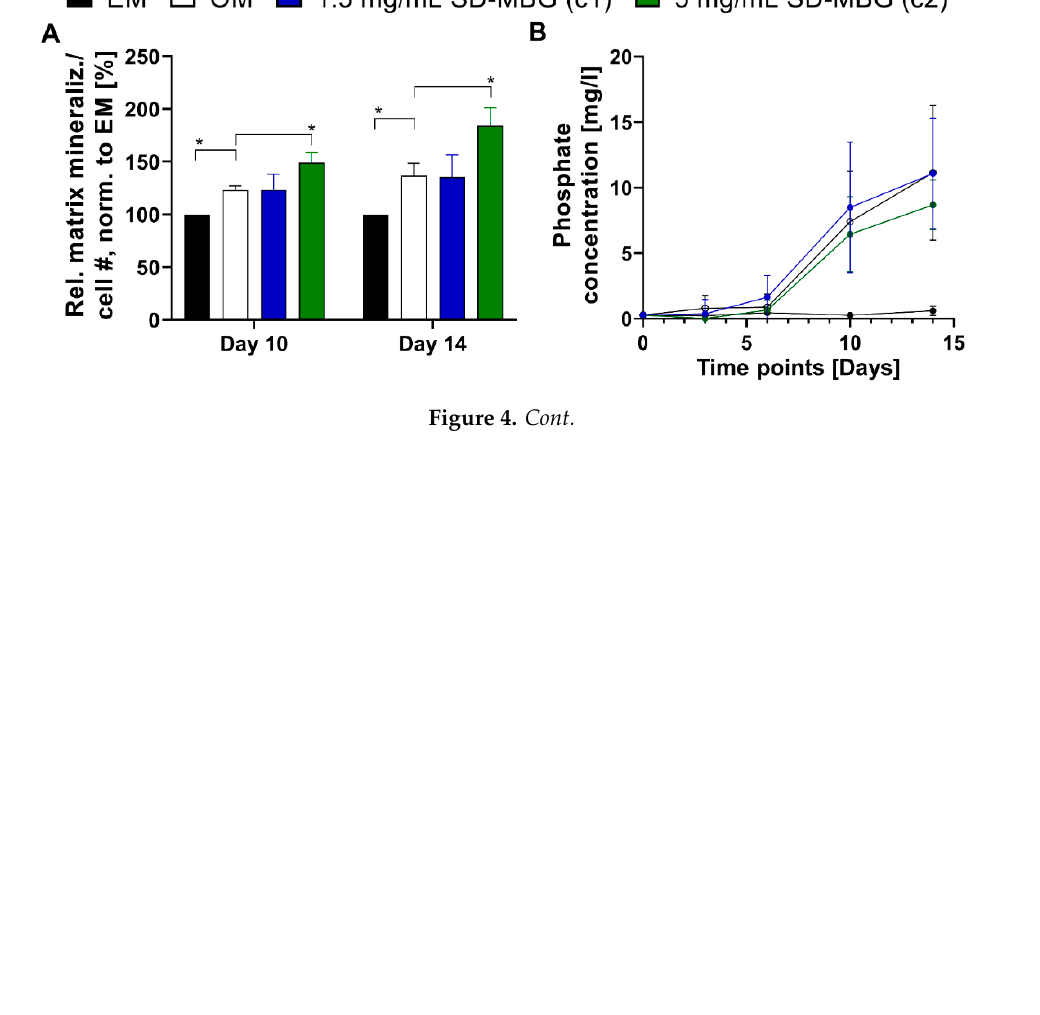
Figure 4. Matrix mineralization and free phosphate accumulation in supernatant of hMSCs upon osteogenic induction and continuous exposure to SD-MBG dissolution products over 14 days. ( A ) Osteogenic differentiation induction in hMSCs by culture in osteogenic medium (OM) and exposure to SD-MBG ionic extracts in OM. Relative matrix mineralization depicted as alizarin red (AR) optical density over cell count (DAPI signal), normalization to cells cultured in expansion medium (EM) (negative control). Matrix mineralization can be observed in all groups receiving OM (OM, concentration 1 (c1) = 1.5 mg/mL SD-MBGs and concentration 2 (c2) = 5 mg/mL SD-MBGs), with SD- MBG in c2 inducing significantly higher mineralization compared to OM group; n = 3 hMSC donors with ≥ 3 technical replicates each. One-way ANOVA with Dunnetts’s multiple comparison test was performed using OM as comparator. ( B ) Quantification of free phosphate accumulation in supernatant over time. In all groups receiving OM, an increase in phosphate amount can be observed starting at day six. n = three hMSC donors with three technical replicates. ( C ) At day 14 of osteogenic induction, OsteoImage staining (green) combined with nuclei staining (DAPI, blue) was conducted, imaged at 10×, scale bar = 100 µm. Representative images are shown for n = three hMSC donors. Arrows in the OM group point at mineralized nodules. Note the substantially increased matrix mineralization for the SD-MBG group, here shown as representative images from c2. p -values for statistical significance were * p < 0.05. 3.3. In Vivo BMP-2 Release from SD-MBG Is Beneficial for the Bone Healing Process